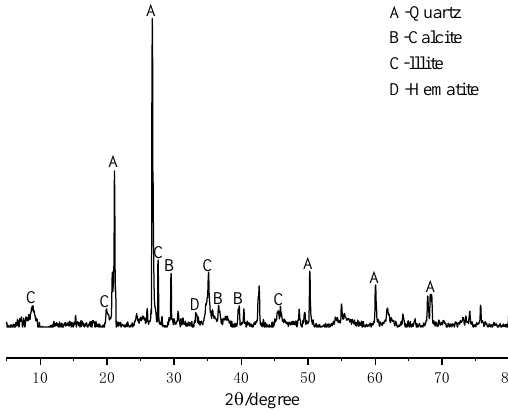
Figure 2. XRD diffractograms of shield mud.